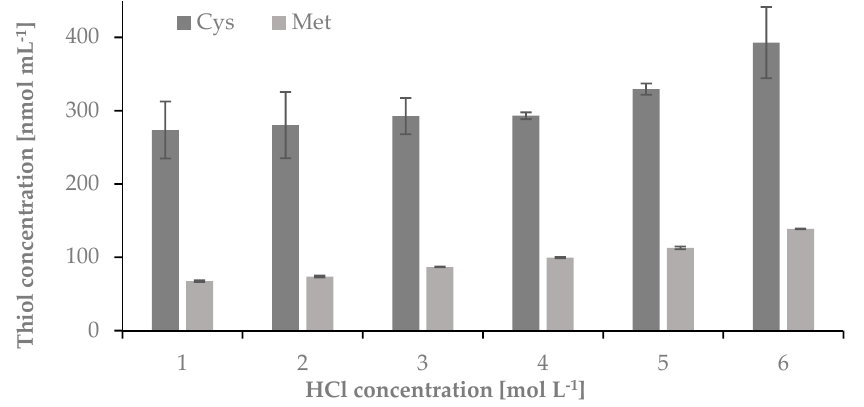
Figure 3. The influence of HCl concentration on the hydrolysis yield of nail plate samples, measured as signals of cysteine-2-chloro-1-methylquinolinium tetrafluoroborate and methionine- o -phthaldialdehyde-N-acetylcysteine derivatives; n = 3.